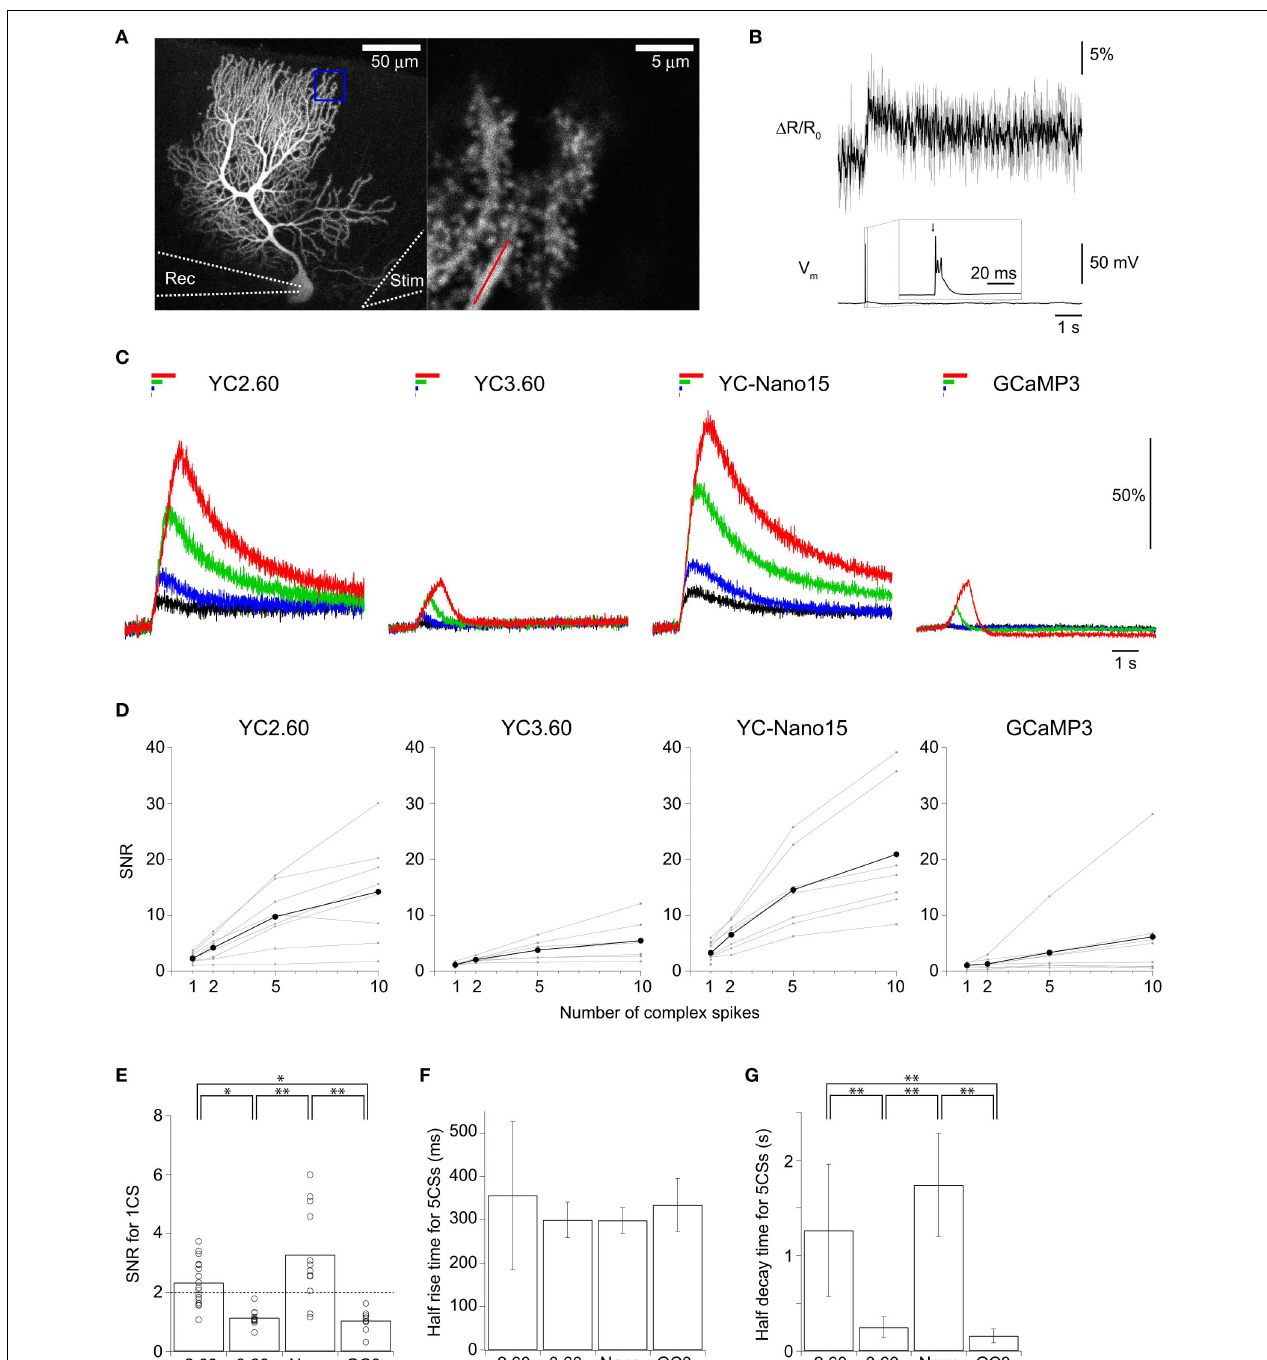
FIGURE 3 | Quantitative comparison of GECIs in cerebellar Purkinje cells. (A) Maximum intensity projection image (Venus emission) of an E12:P56 YC2.60-expressing Purkinje cell (left), and an expanded single z -section image within the blue box (right). Line-scan imaging was performed along the distal dendrite as indicated by the red line. Rec, an eletrode for patch-clamp recording; stim, an electrode for extracellular stimulation. (B) Smoothed Δ R/R 0 traces ofYC2.60 in response to a single complex spike (CS) for individual trials (gray) and the mean across trials (black). (C) Δ R/R 0 (YC) or Δ F/F 0 (GC3) traces in response to 1 (black), 2 (blue), 5 (green), 10 (red) CSs evoked at 10Hz. Each trace is the mean across cells ( n = 8 cells forYC2.60, 7